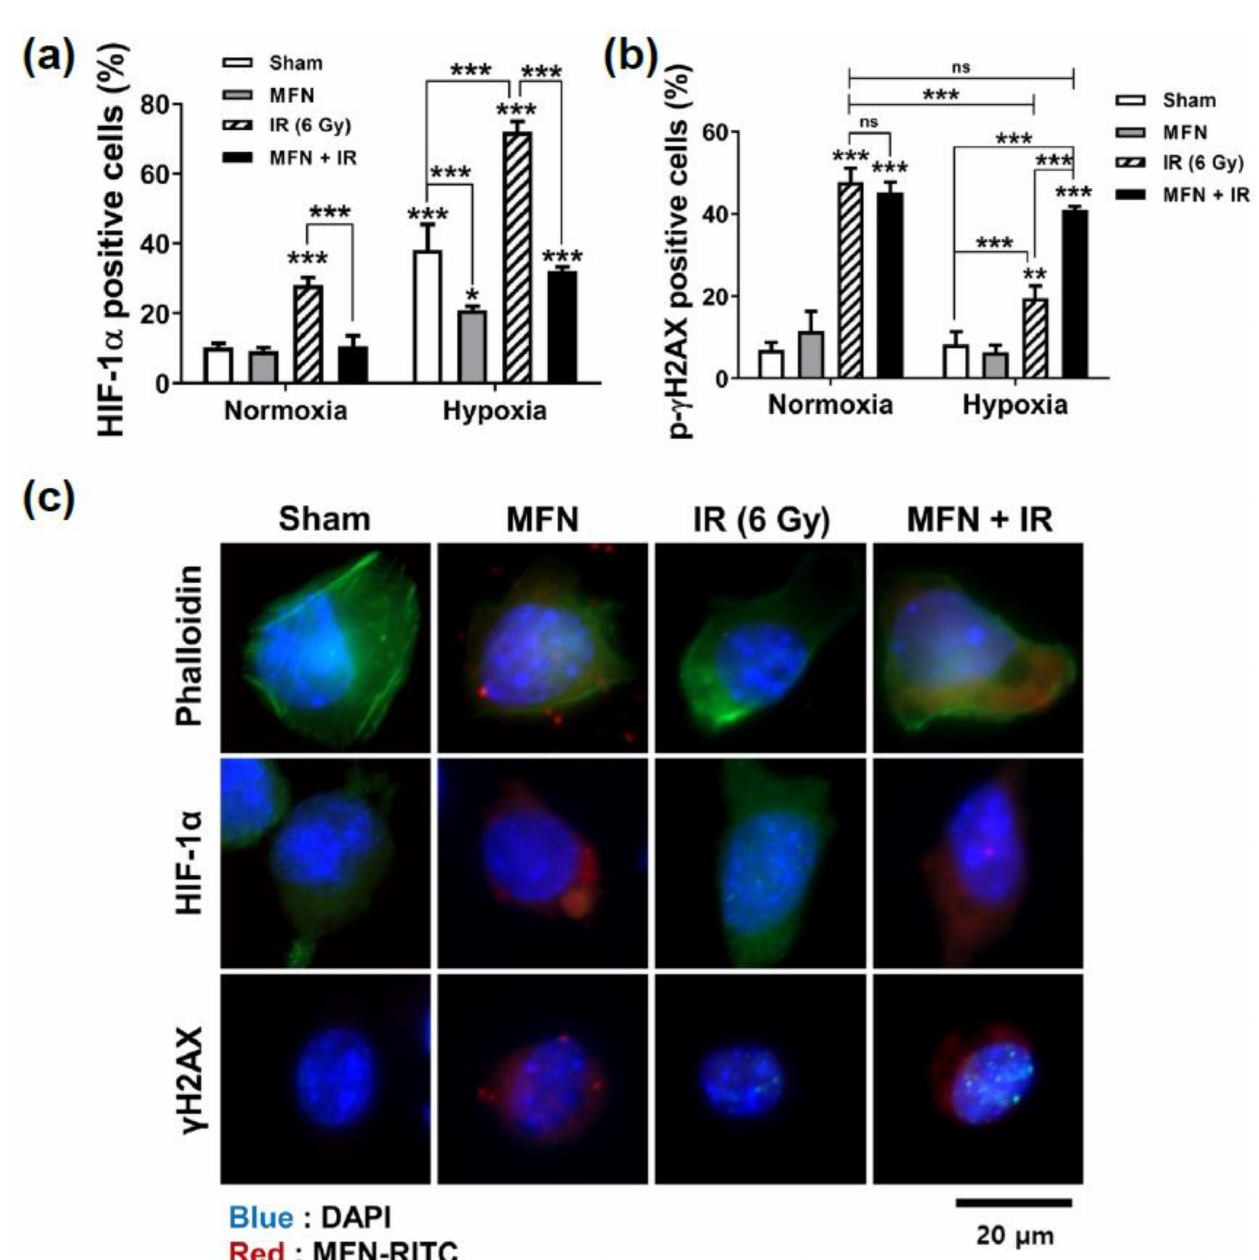
Figure 3. Effects of MnFe 2 O 4 nanoparticles (MFN) on HIF-1 α expression and DNA damage following ionizing radiation (IR). ( a ) Increased HIF-1 α expression under hypoxia was suppressed by MFN treatment. Flow cytometry was performed as described in the Materials and Methods. ( b ) Decreased DNA damage under hypoxia was recovered by MFN treatment. ( c ) Representative immunofluorescent images of HIF-1 α and γ H2AX. Blue: DAPI; red: MFN; green: phalloidin, indicating HIF-1 α and γ H2AX. The values represent the mean ± SD; * p < 0.05; ** p < 0.01; *** p < 0.001; ns, not